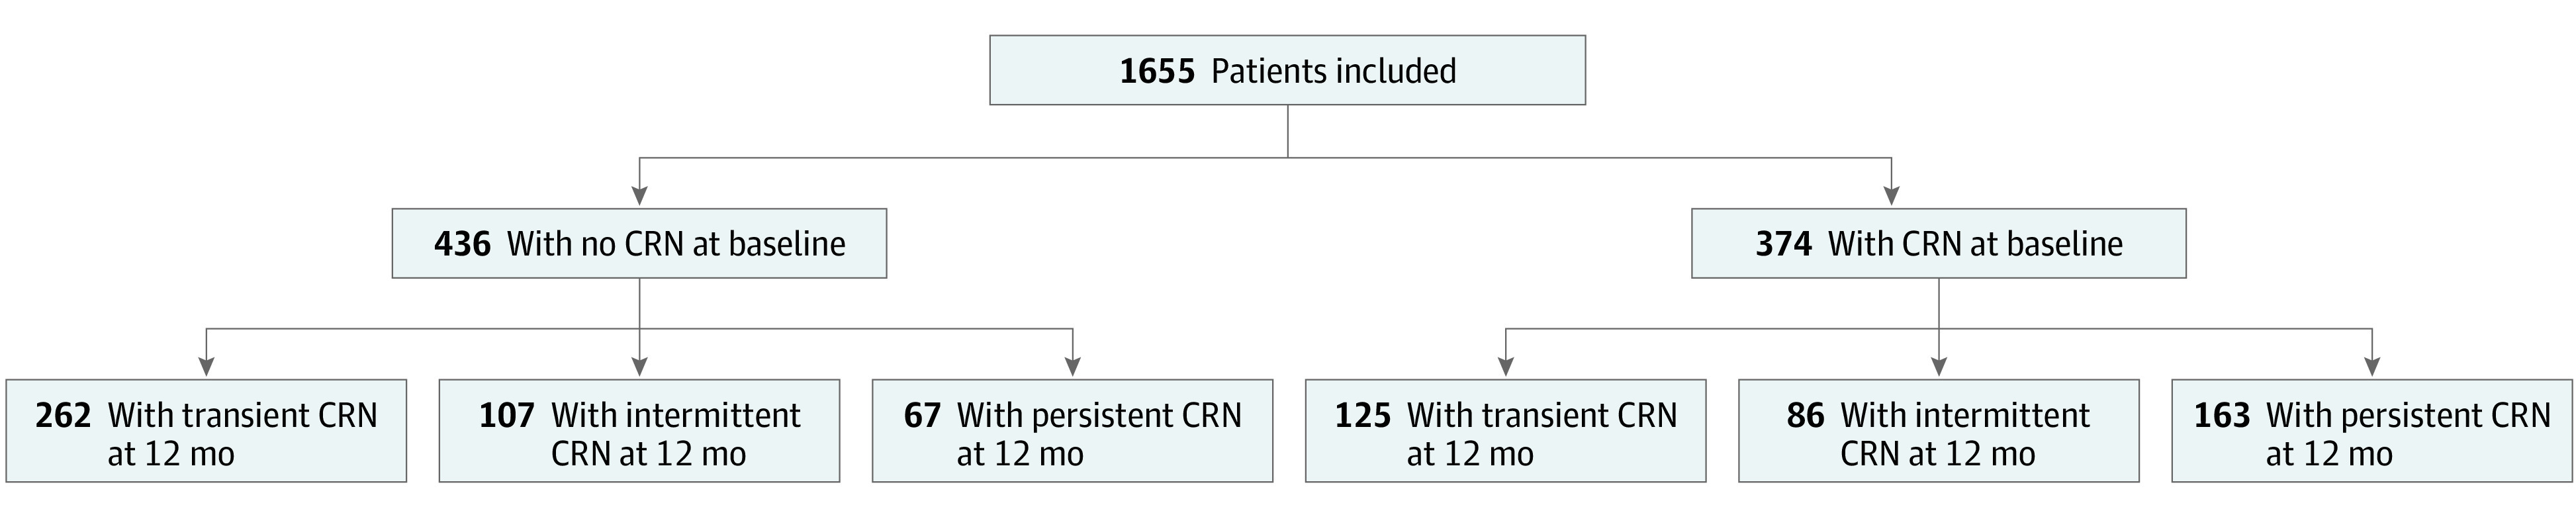
Cost-Related Medication Nonadherence (CRN) Outcomes Measured at Baseline and Throughout the Study Period